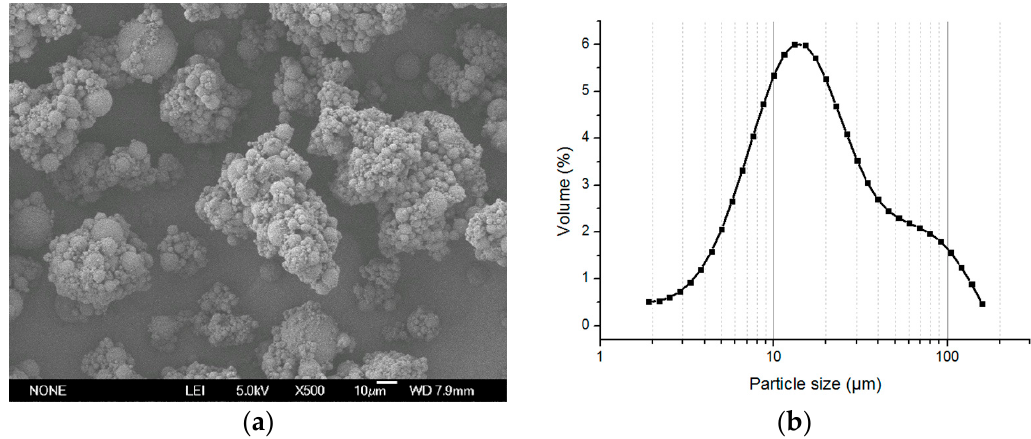
Figure 7. The photographs of the polymer microspheres of the ( a ) membrane emulsification (SEM ˆ 500)